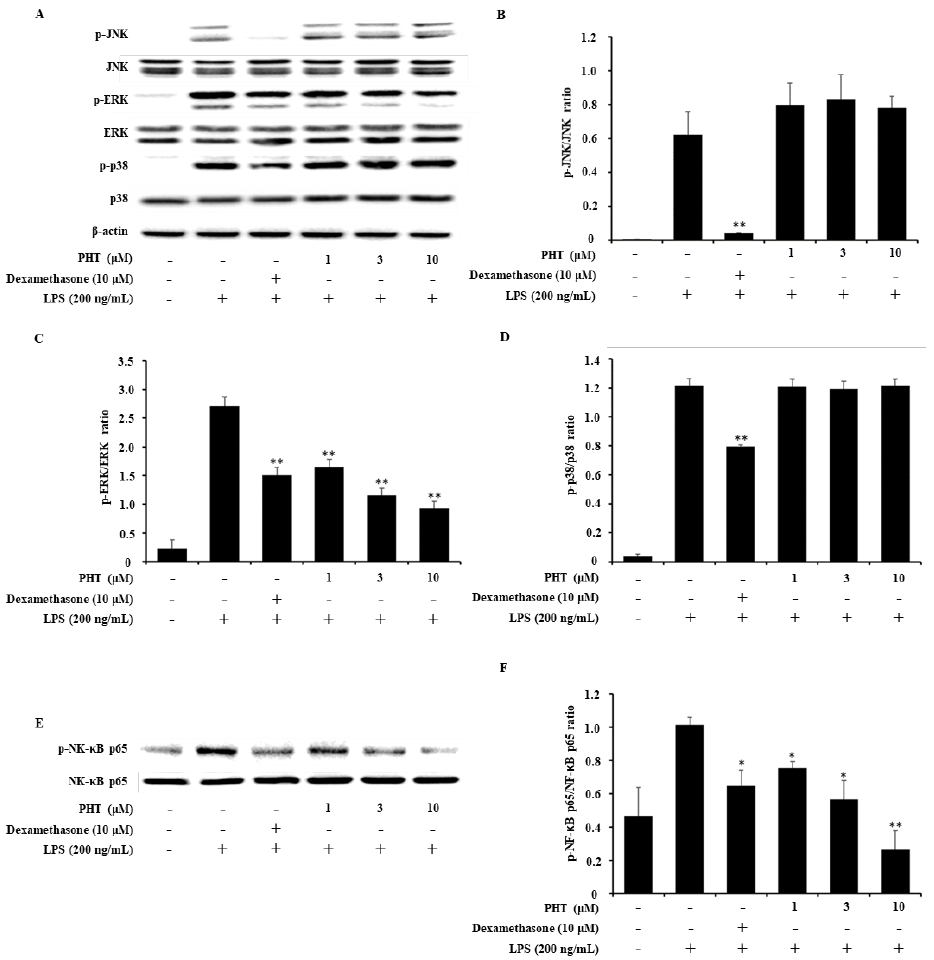
Figure 3. Effect of PHT on the LPS-induced MAPK and NF-κB signaling pathways. J774 cells were treated with LPS (200 ng/mL) for 30 min to 1 h after pretreatment with 10 μM dexamethasone or 1, 3 or 10 μM PHT for 1 h. ( A ) MAPK expression was analyzed by immunoblotting. The band optical densities of ( B ) JNK, ( C ) ERK and ( D ) p38 were measured. ( E ) NF-κB p65 subunit expression was measured by immunoblot analysis, and ( F ) the band optical density was calculated. The immunoblot data are representative of three independent experiments. The values are presented as the mean ± SD of three individual experiments. * p < 0.05, ** p < 0.01 compared with the LPS-alone group. The optical densities were analyzed by ImageJ software.